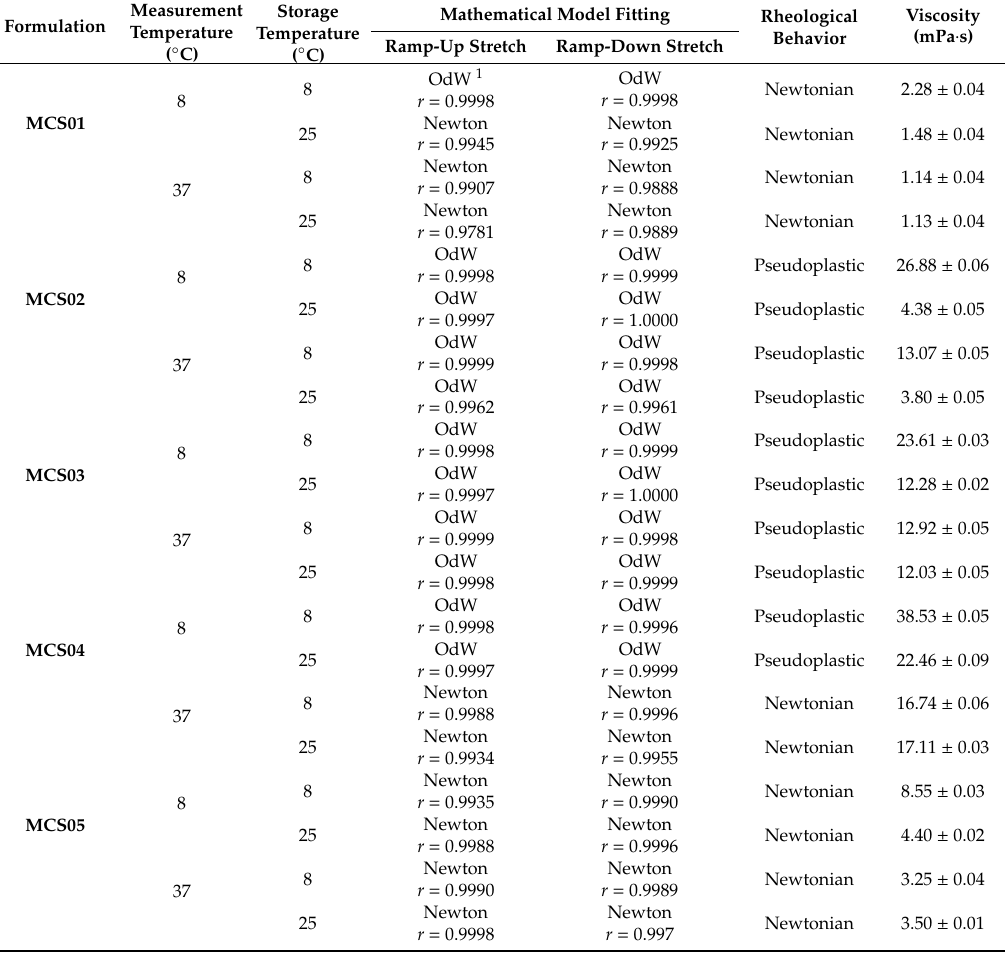
Table 4. Rheological characterization 6 months after preparation ( t 6 ) of polymeric solutions at di ff erent temperatures of measurement and